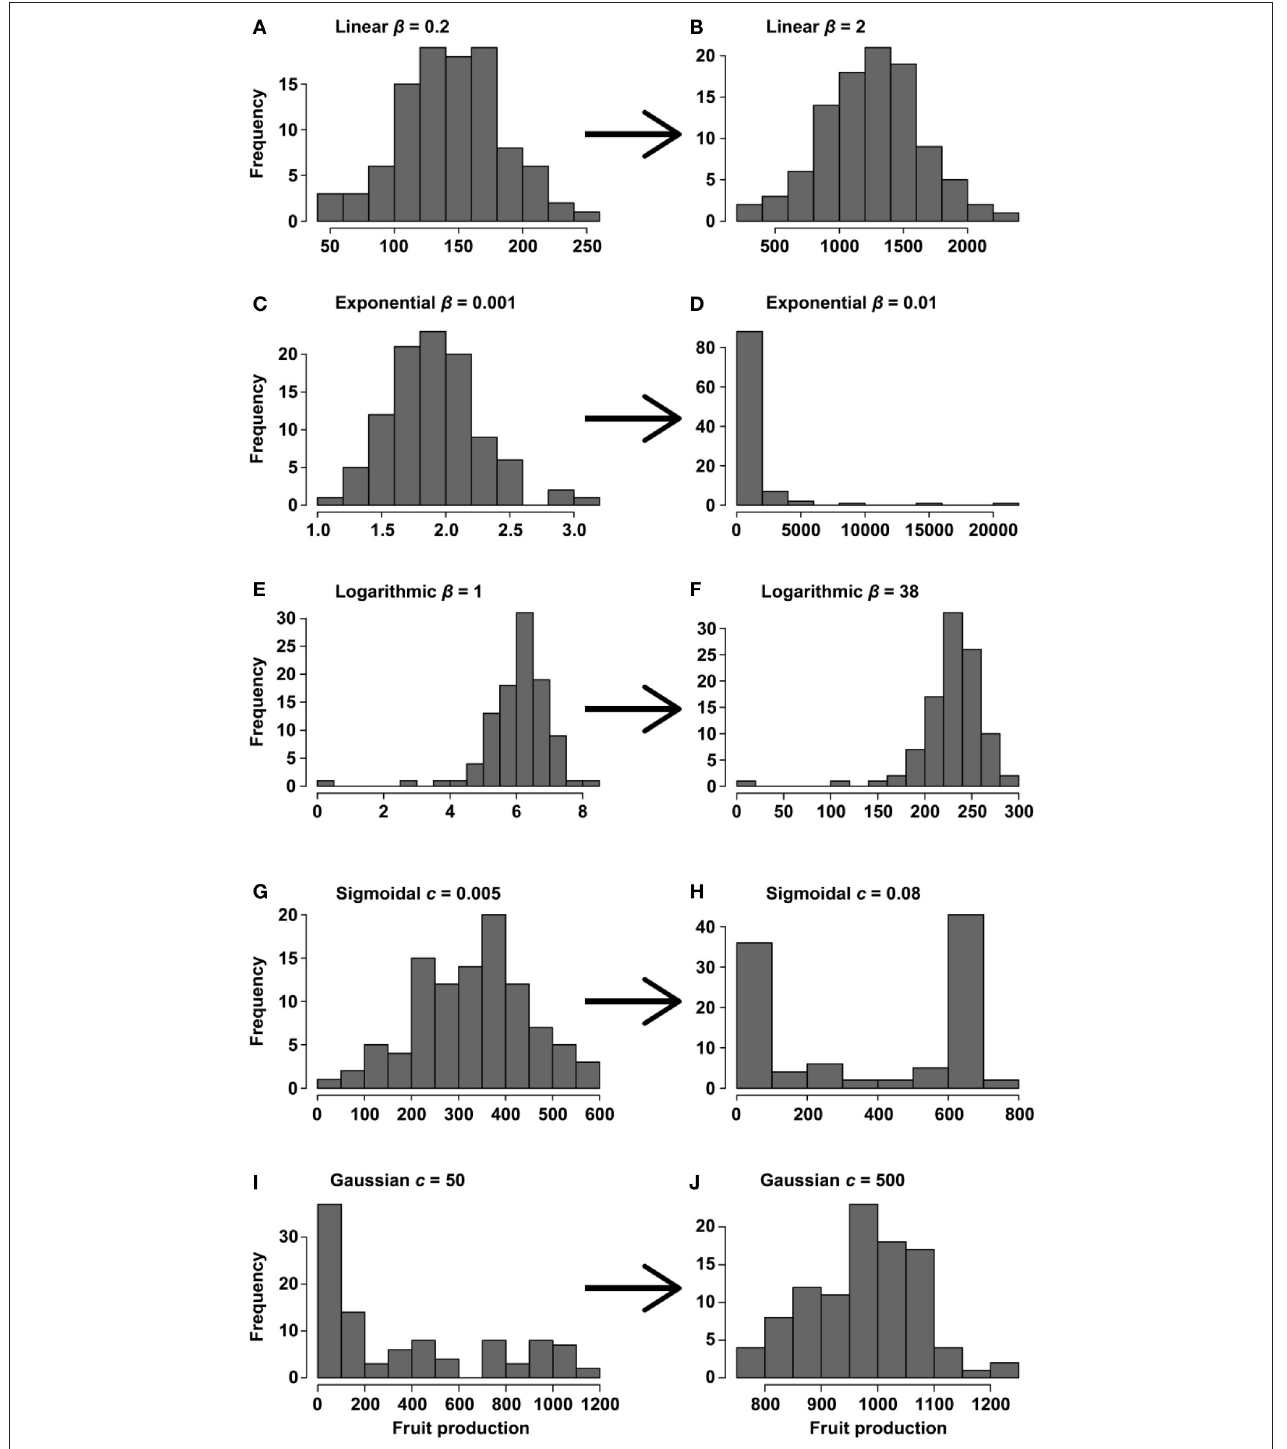
FIGURE 2 | Histograms of the change in the distribution of fruit production for different slopes and functions [linear (A,B) , exponential (C,D) , logarithmic (E,F) , sigmoidal (G,H) , and Gaussian (I,J) ] assuming that fruit production depends on a Gaussian meteorological variable with a mean of 600 and an SD of 150 (CV = 0.25). Distributions for low slopes—or c parameters for sigmoidal and Gaussian functions— (A,C,E,G,I) and distributions for high slopes (B,D,F,H,J) . The code for this simulation is provided in Supplementary Material, section 1.